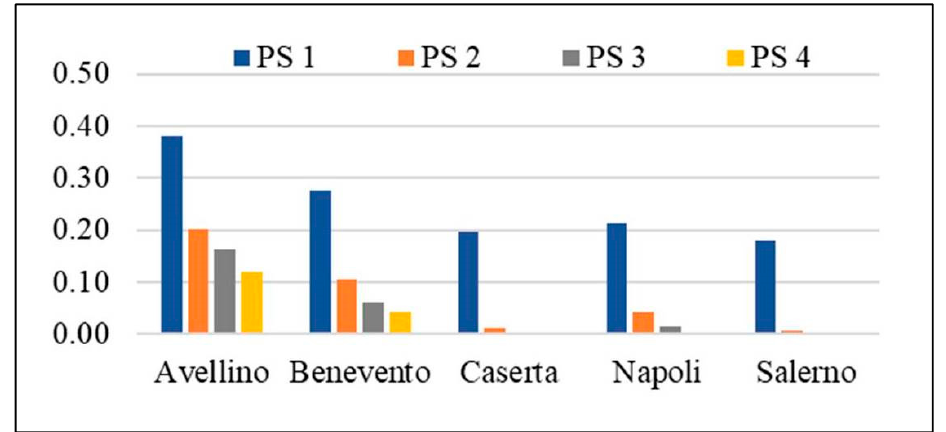
Figure 14. 2-storey building Campania region: combined structural and energetic index.